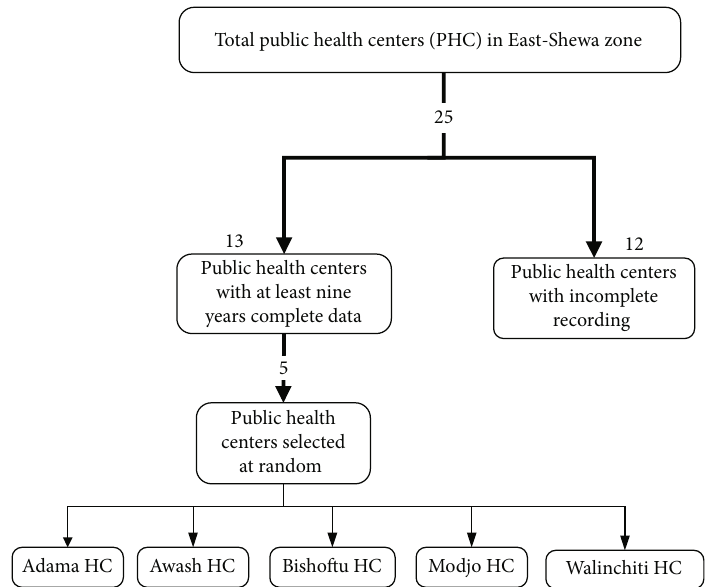
Figure 1: A fl ow diagram showing the steps taken for selecting the facilities within the East-Shewa